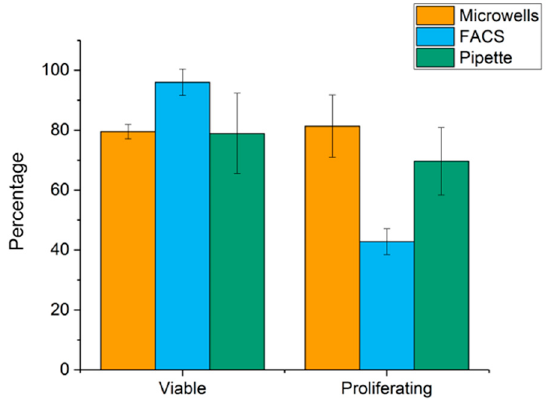
Figure 3. Cell viability and colony formation after punching compared to FACS sorting and pipetting. Percentage of viable cells and the percentage of cells that formed colonies is shown.